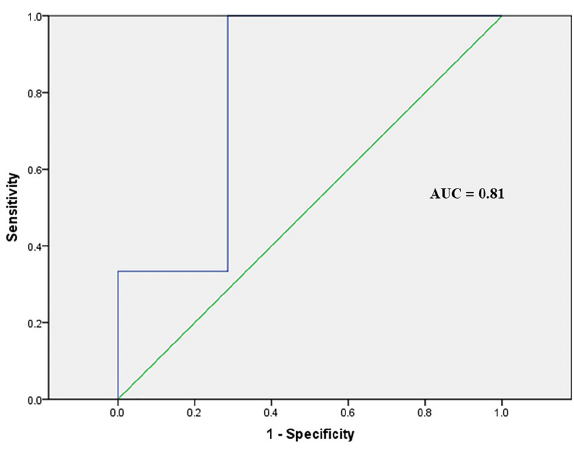
Fig. 7. The ROC technique validation result. ROC, receiver operating characteristics.